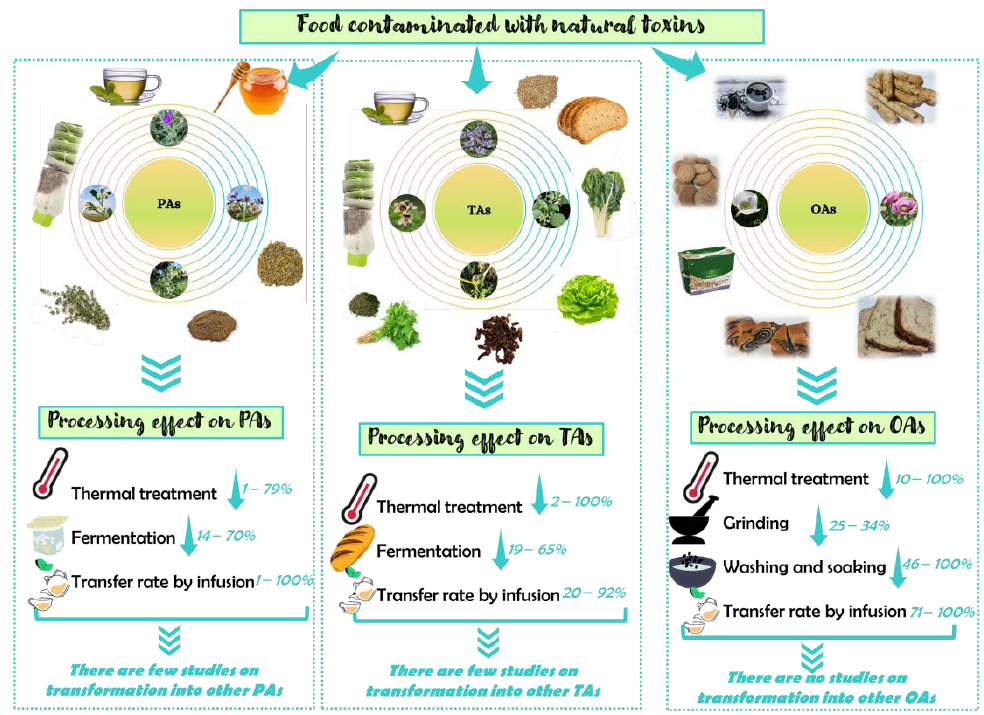
Figure 4. Overview of the occurrence and effect of food processing and culinary preparation on pyrrolizidine (PAs), tropane (TAs) and opium (OAs) alkaloids according to the works included in this revision and currently available in the literature.